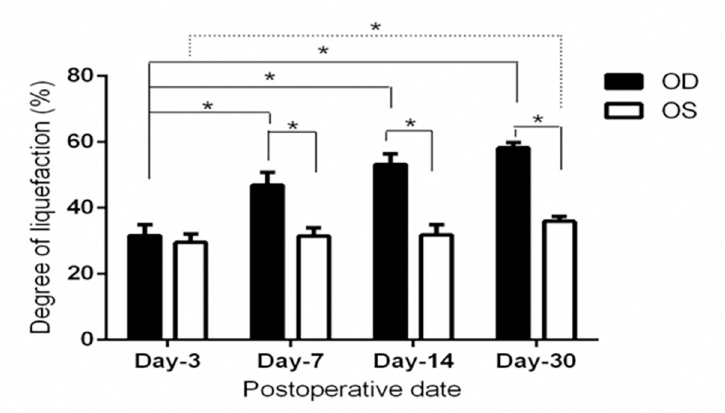
Fig 1. Comparison of liquefaction degree of binocular vitreous during the course of VH ( � p < 0.05).